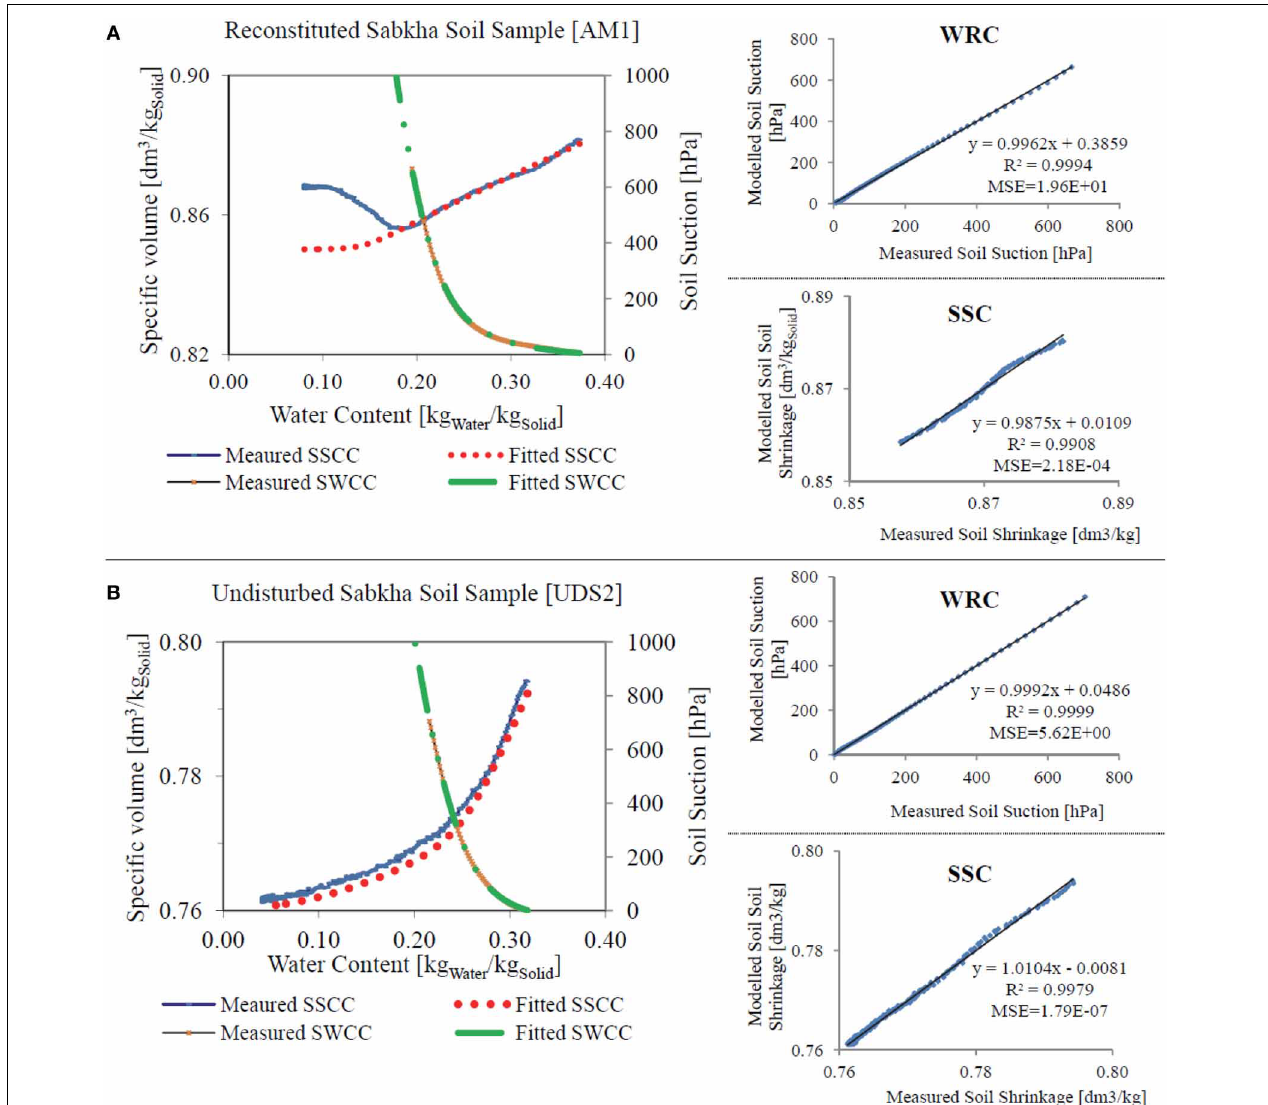
FIGURE 9 | Examples of modeling the soil moisture characteristic curves for Sabkha soil. (A) Reconstituted sample [AM1]; (B) Undisturbed sample [UDS2]. WRC, Water Retention Curve; SSC, Soil Shrinkage Curve; R 2 , coefficient of determination; MSE, Mean Square